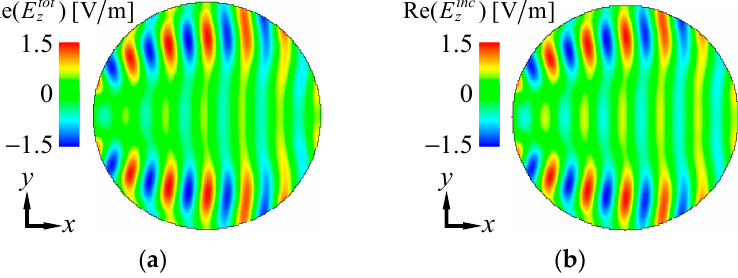
Figure 14. Geometry of inverse scattering analysis including unwanted obstacles.